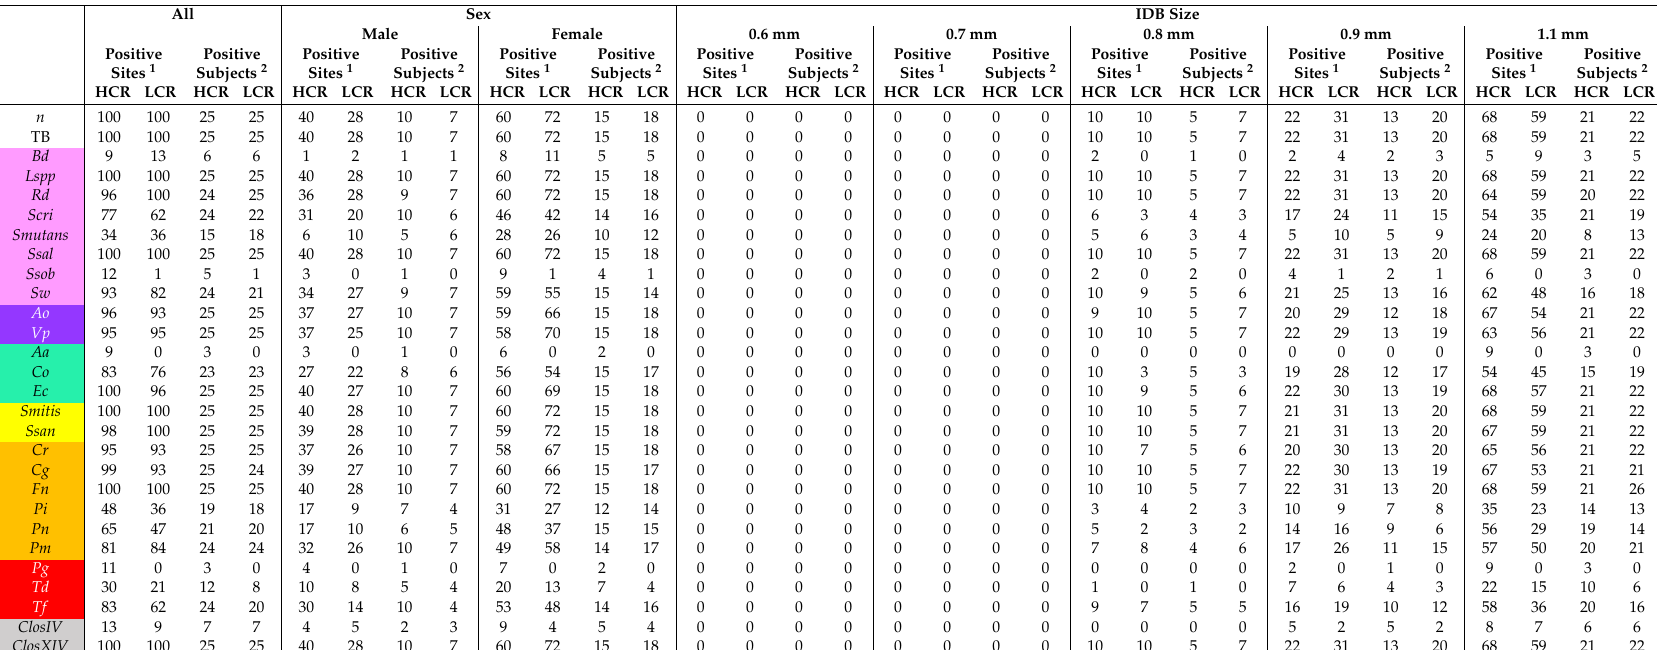
Table 4. Distribution of the pathogens according to sites and